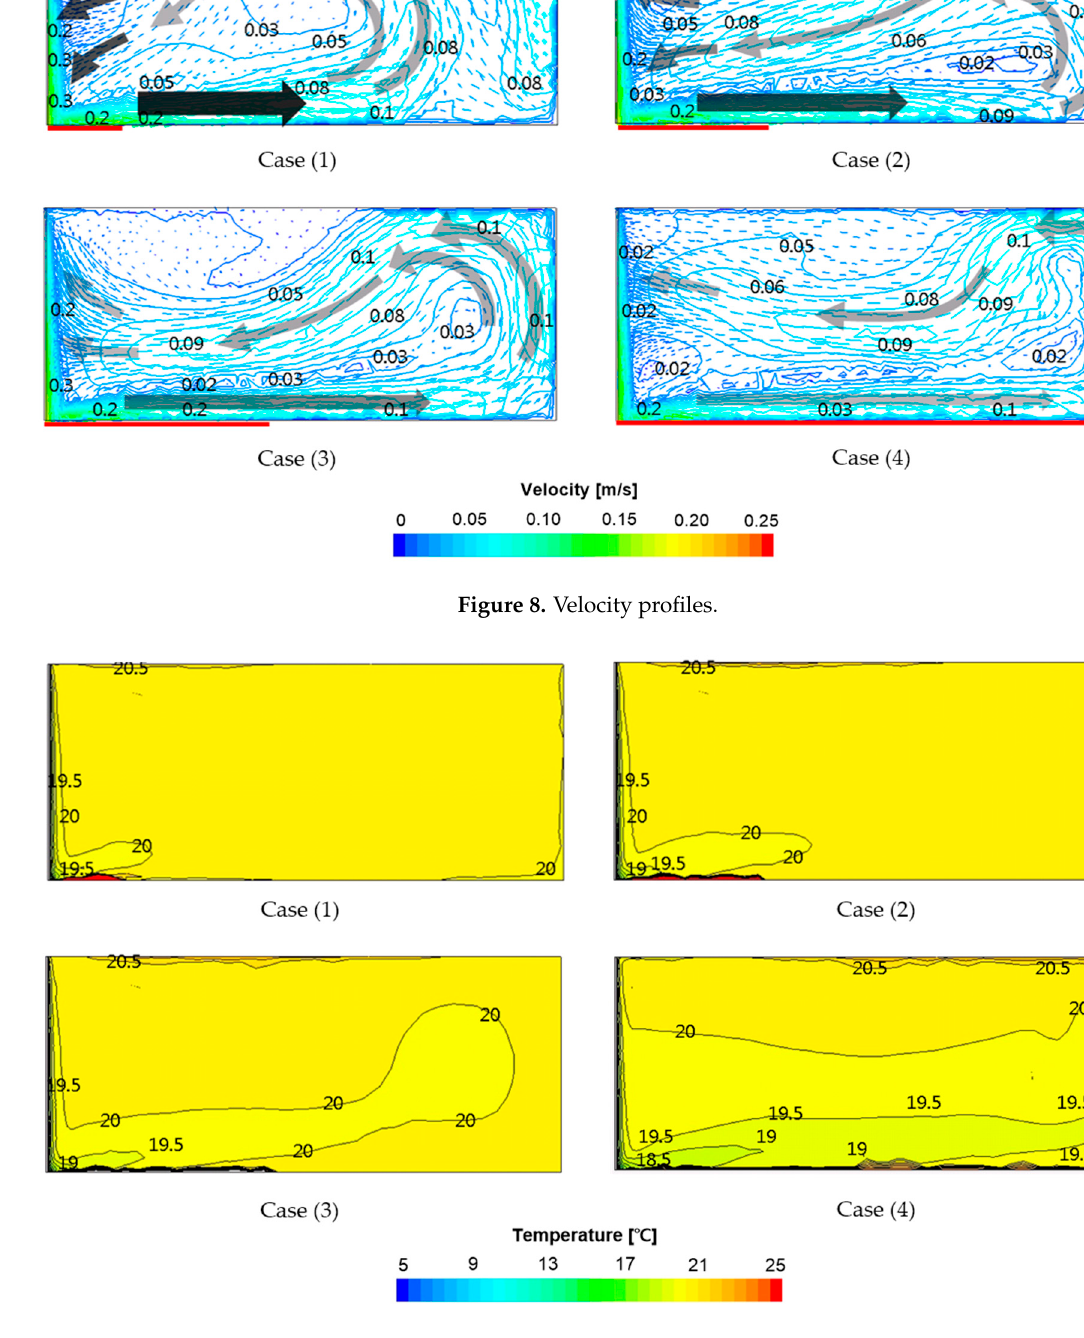
Figure 9. Distribution of temperature.